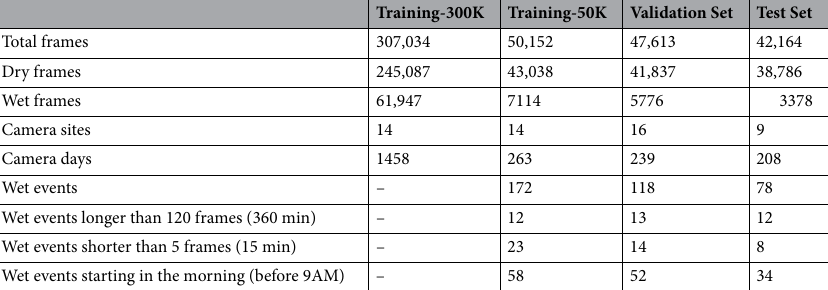
Table 2. Distribution of the training, validation and testing